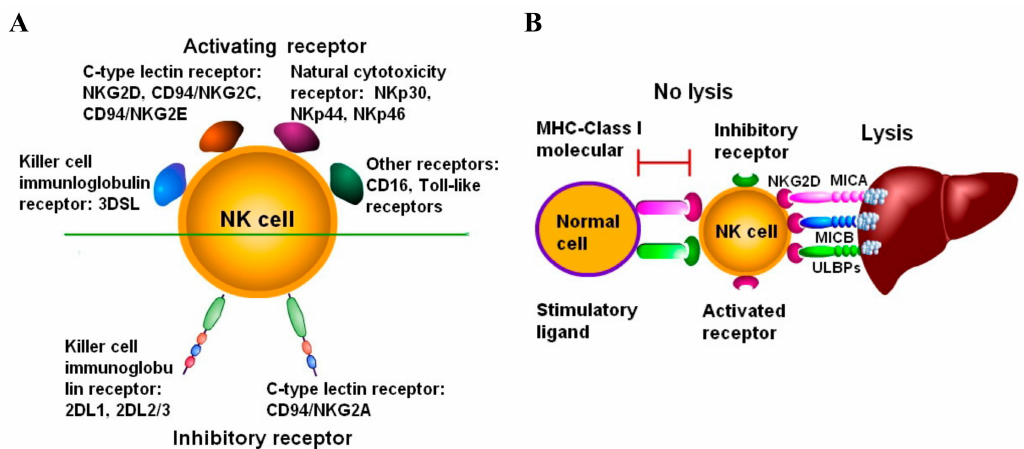
Figure 1. NK cell receptors and expression. ( A ) The types of receptors expressed on the surface of NK cells. Activating receptors can be expressed on NK cells, such as NKG2D, C, NKp46, CD16, and others, and multiple inhibitory receptors also can be expressed on NK cells, such as NKD2A, NKG2B, and so on. ( B ) Balanced expression of activating receptor and inhibitory receptor. Based on the dominant expression of inhibitory receptor, NK cells have no cytotoxic e ff ect on normal cells with poor expression of NKG2D